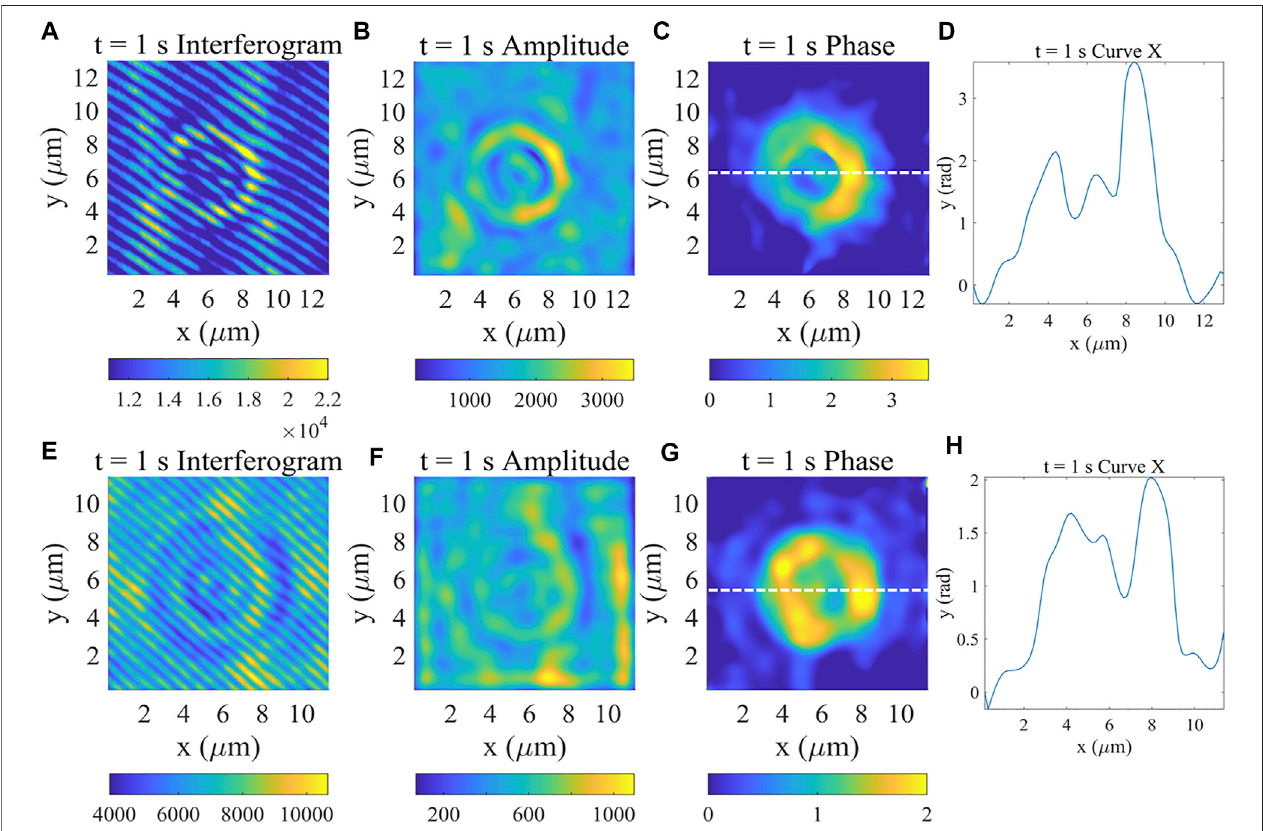
FIGURE 3 | Complex fi eld and Phase measurement results of red blood cells without and with anticoagulant (the results of the fi rst row are without anticoagulant). (A,E) Interferogram image at 1 s (B,F) Amplitude image at 1 s (C,G) Phaseimage at 1 s (D,H) Phase pro fi le ofhorizontal direction curves at thelocationindicated bythe white dashed line shown in (C,G)